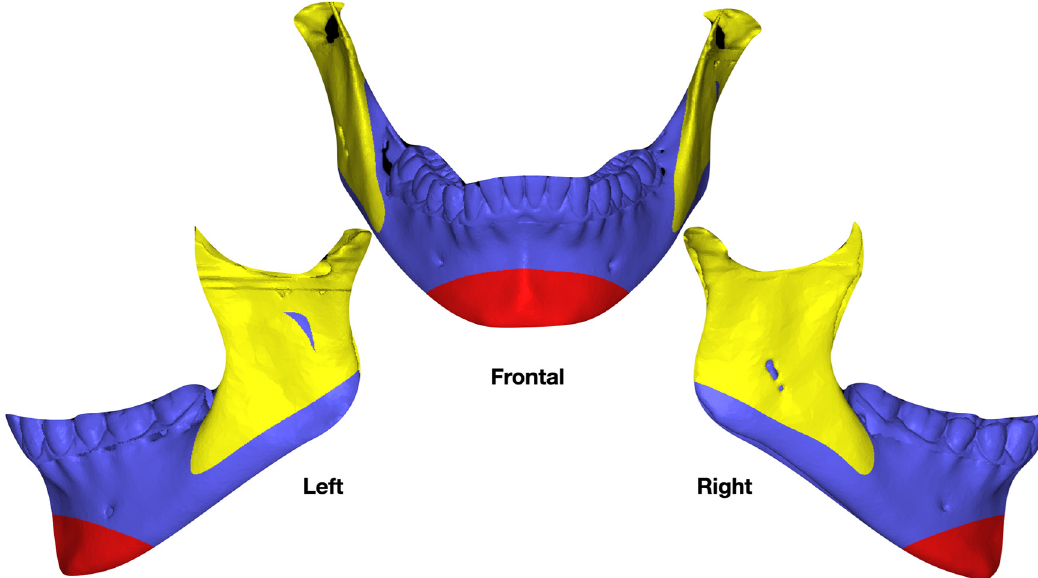
Fig. 1. Design of bilateral osteotomy sagittal split modi fi ed (Frontal view, Left view, Right view). *Digital Images have been taken in NemoStudio, NemoFAB, Version 2019.